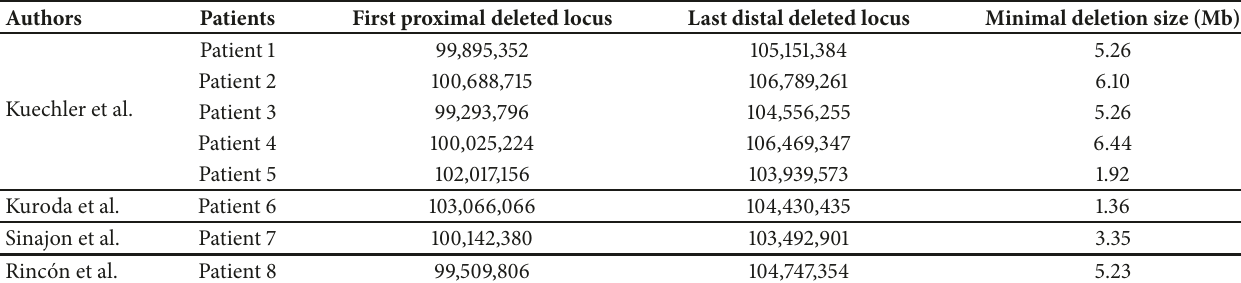
Table 2: Summary of deletiondata of patients 1–5from Kuechleret al.;patient6from Kurodaet al.;and patient7from Sinajonet al.compared with the present